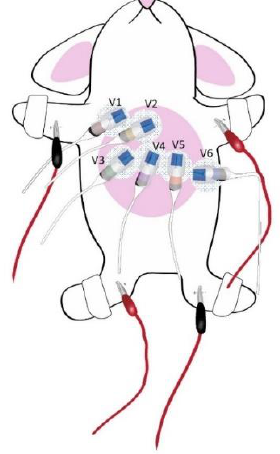
Figure 1. Schematic presentation of electrocardiographic recordings from the rabbits. The six precordial leads and limb leads were attached as illustrated to the anterior thorax of the rabbits. The locations of precordial leads were placed as follows - V2 and V4: in the 4th and 5th intercostal space on the sternum, respectively; V1 and V3: in the 4th and 5th intercostal space along the right margin of sternum, respectively; V6: in the 5th intercostal space along the mid-axillary line and V5 was mid-way between V4 and V6.